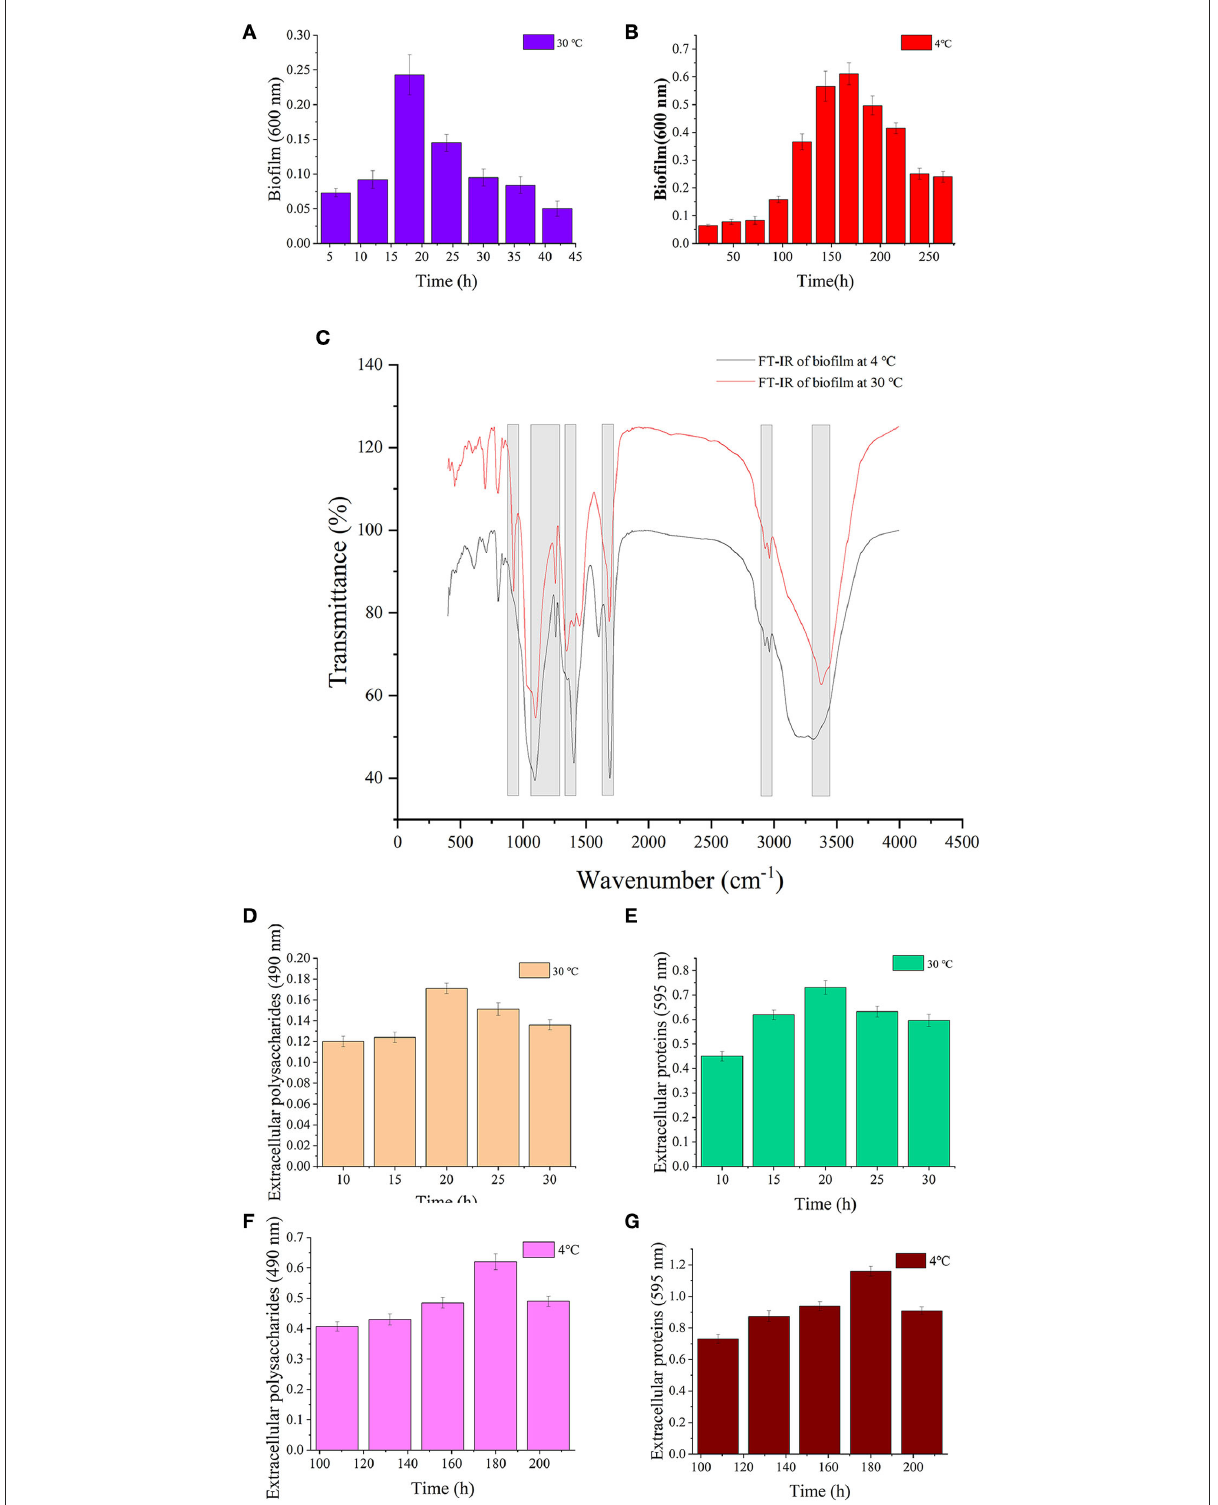
FIGURE4 Biofilm analysis of S. putrefaciens WS13. (A) Biofilm biomass formed under 30 ◦ C. (B) Biofilm biomass formed under 4 ◦ C. (C) FT-IR spectra of S. putrefaciens WS13 under 30 ◦ C (red line) and 4 ◦ C (black line). (D) The extracellular polysaccharides content of EPS under 30 ◦ C. (E)